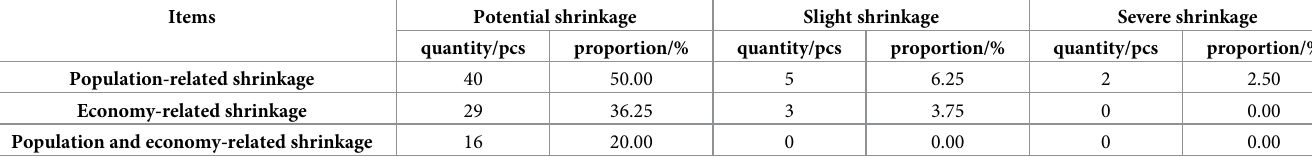
Table 3. Hierarchical statistics of shrinking cities in the Yellow River Basin from 2010 to 2018.